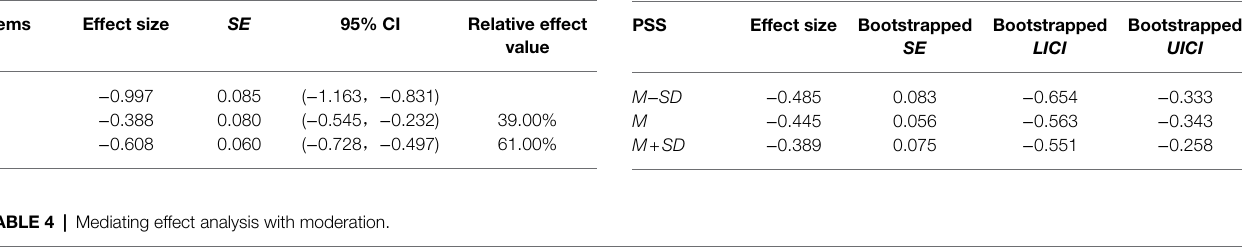
TABLE 6 | The impact of negative emotions on subjective wellbeing at different levels of perceived social support.